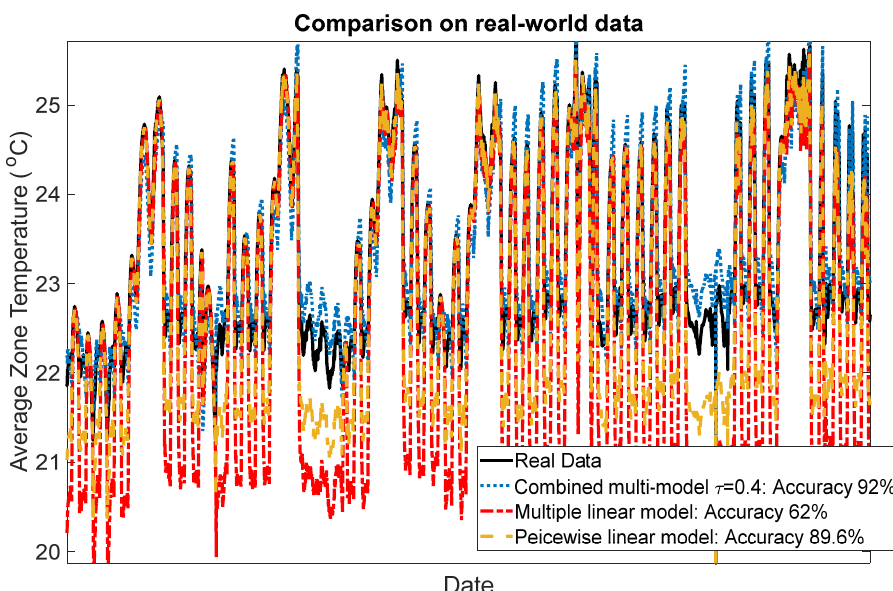
Figure 10. Magnified results of the three models’ performances.